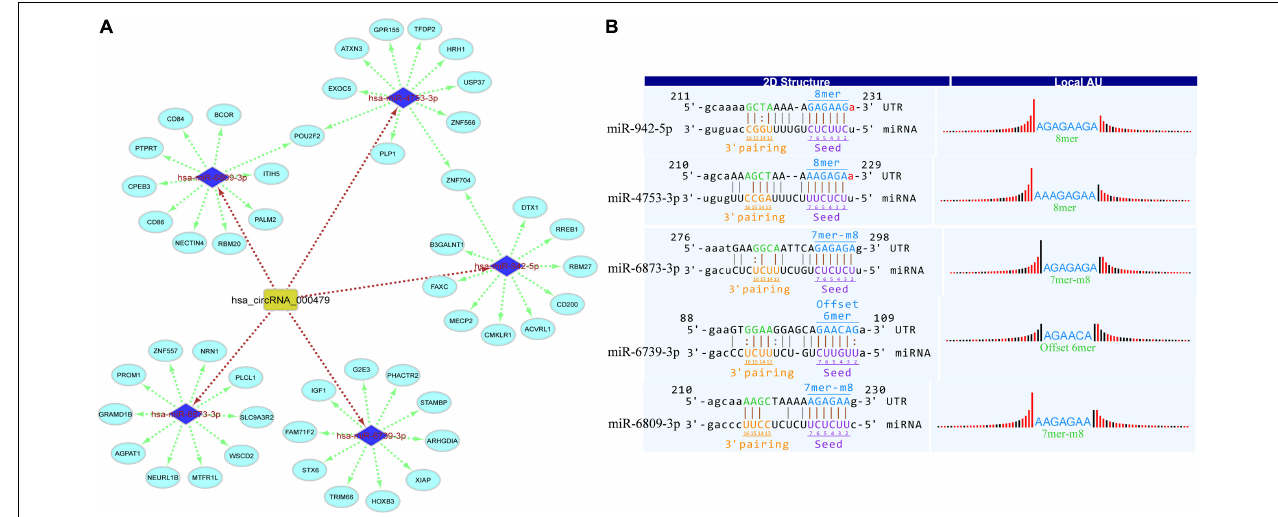
FIGURE 5 | (A) CircRNA_000479_miRNA_mRNA interaction network constructed by Cytoscape. (B) Top MREs of hsa_circRNA_000479 are shown, predicted by Targetscan and miRanda databases.